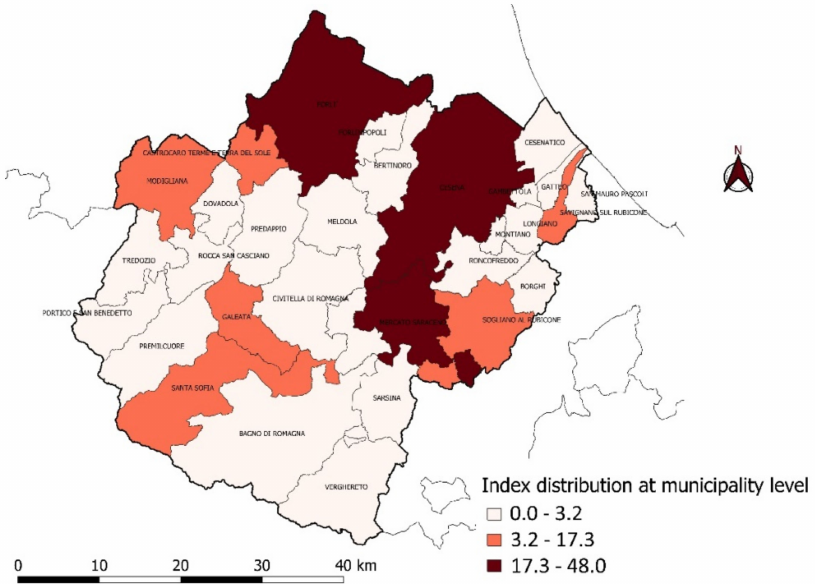
Figure 8. Index distribution at the territorial level within the municipalities of Forl ì -Cesena